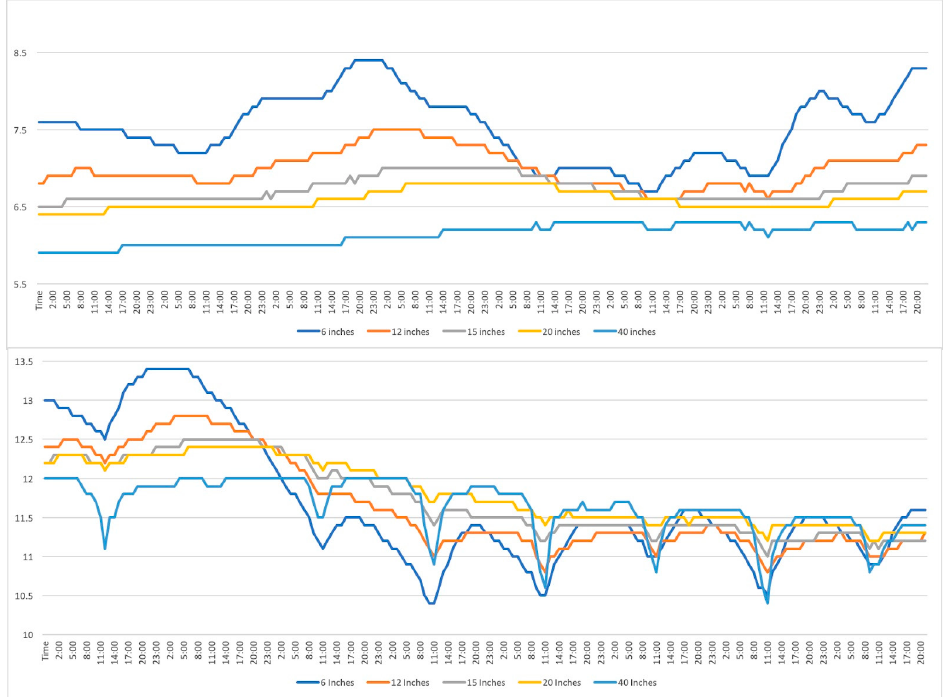
Figure 13. ( top ) Soil temperature data from the Mascoma River for the week leading up to May 11th, 2017 ( bottom ) Soil temperature data from the Mascoma River for the week leading up to 22 October 2017.